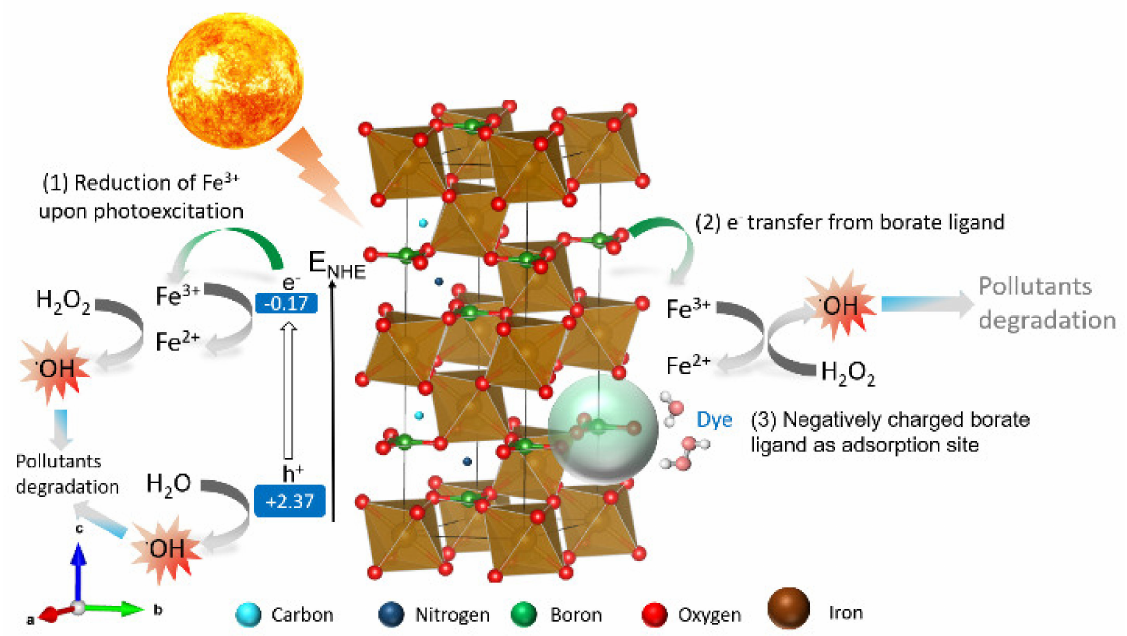
Figure 10. A schematic diagram showing the unit cell of C,N-doped FeBO 3 and the proposed mechanism of MB degradation on the C,N-doped FeBO 3 system. The aqua blue spheres—carbon, blue—nitrogen, green—boron, red—oxygen, and